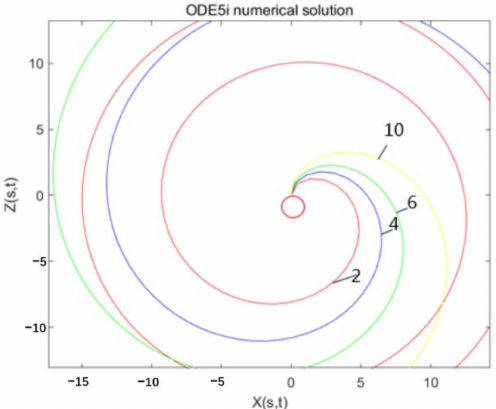
Figure 8. Using the implicit Runge-Kutta method ODE15I to solve the jet model. When the iter- ation interval is [0:300], Rb = 2, We = 10, the effect of different accuracy settings on the solution iteration. ( a ) ‘RelTol’ = 1 × 10 − 3 , ‘AbsTol’ = 1 × 10 − 6 ; ( b ) ‘RelTol’ = 1 × 10 − 4 , ‘AbsTol’ = 1 × 10 − 6 ; ( c ) ‘RelTol’ = 1 × 10 − 5 , ‘AbsTol’ = 1 × 10 − 6 ; ( d ) ‘RelTol’ = 1 × 10 − 6 , ‘AbsTol’ = 1 × 10 − 6 . The jet trajectory obtained by using different Weber numbers under the implicit Runge-Kutta method is shown in Figure 9.